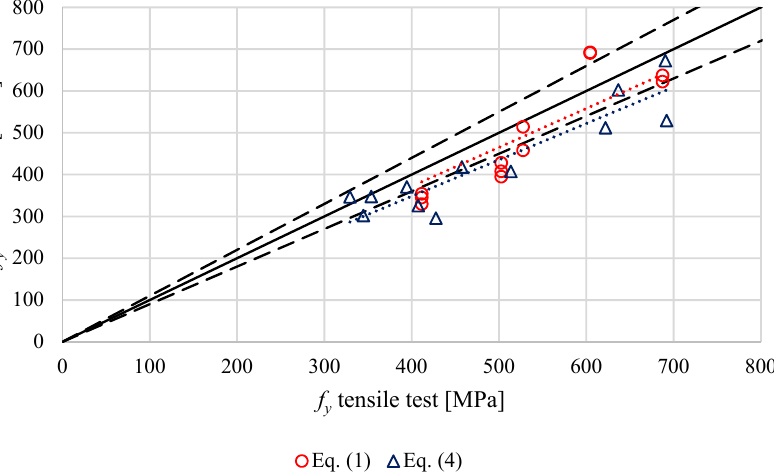
Figure 13. Comparison of yield stress values determined in the tensile tests and SPT (blue) or HV (red) estimations. Linear trendlines as dotted